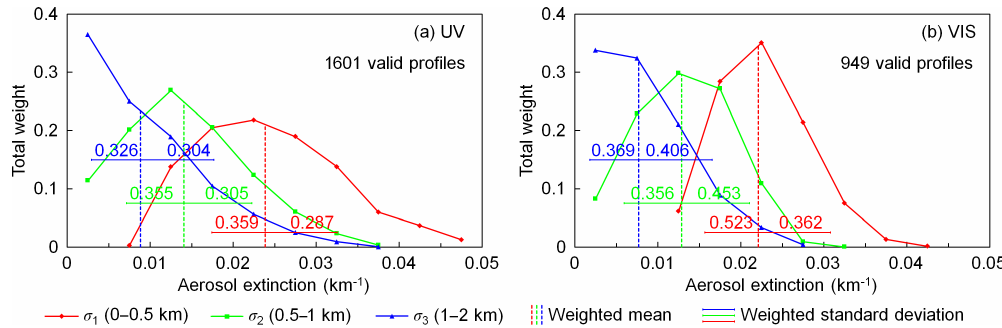
Figure 11. Weight distribution of valid profiles of the (a) UV and (b) VIS bands and results of the scanning cycle on 5 July 2015 at ∼ 16:26UTC (SZA ∼ 64 ◦ , RAA ∼ 97 ◦ ). The weight distributions of the aerosol extinction coefficients of the three layers ( σ are shown as solid curves with different colors. The vertical dashed lines indicate the weighted mean aerosol extinction coefficient of the three layers ( σ 1 ( ˆ x ) , σ 2 ( ˆ x ) , and σ 3 ( ˆ x ) ). The error bars indicate the weighted standard deviation calculated with Eqs. (16) and (17). The numbers on the error bars refer to the total weight ( w ) of the profiles covered by each error bar.